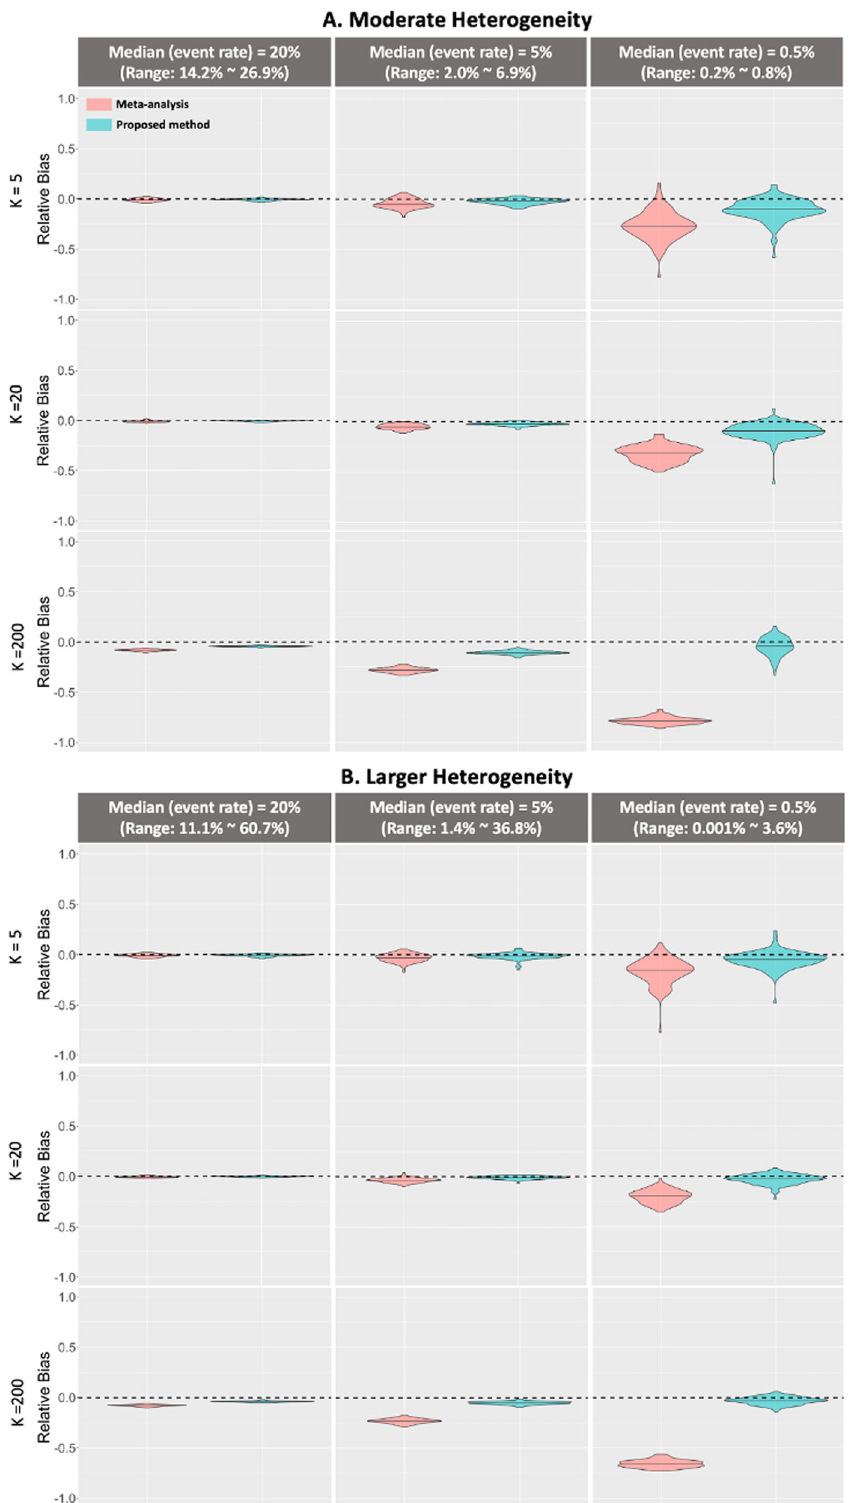
Fig. 3 Simulation study results. Comparison between the relative bias of meta-analysis method (pink) and the proposed dCLR algorithm (cyan). Upper panel: relative bias of the continuous risk factor ’ s coef fi cient estimation compared with the pairwise likelihood method (gold standard) under three scenarios (i.e., median prevalence 20%, 5%, and 0.5%) with moderate heterogeneity in prevalence when the total number of sites is 5, 20, or 200. Lower panel: relative bias of the continuous risk factor ’ s coef fi cient estimation compared with the pairwise likelihood method (gold standard) under three scenarios with median prevalence 20%, 5%, and 0.5% with larger heterogeneity (i.e., larger prevalence range than upper panel) when the total number of sites is 5, 20, or